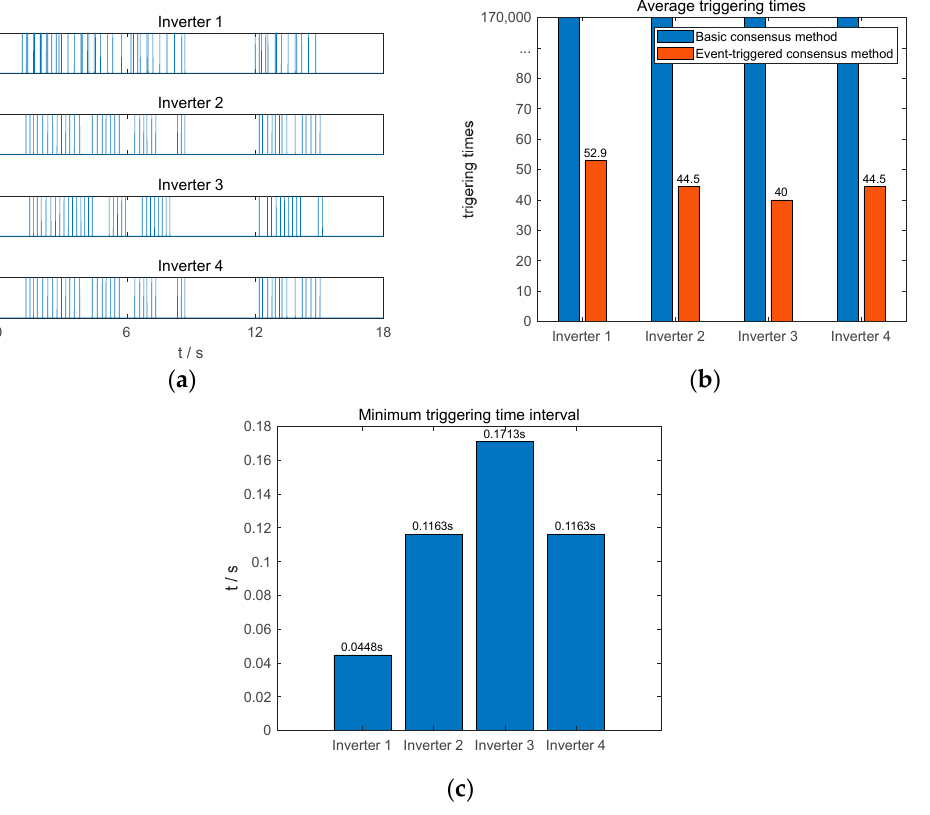
Figure 10. Control performance of consensus algorithm with event-triggered mechanism: ( a ) event- trigger graph; ( b ) average event-trigger times; ( c ) minimum triggering time interval.